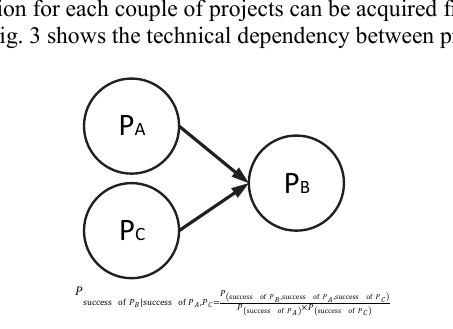
Fig. 3. Technical dependence (3-Variables joint probability